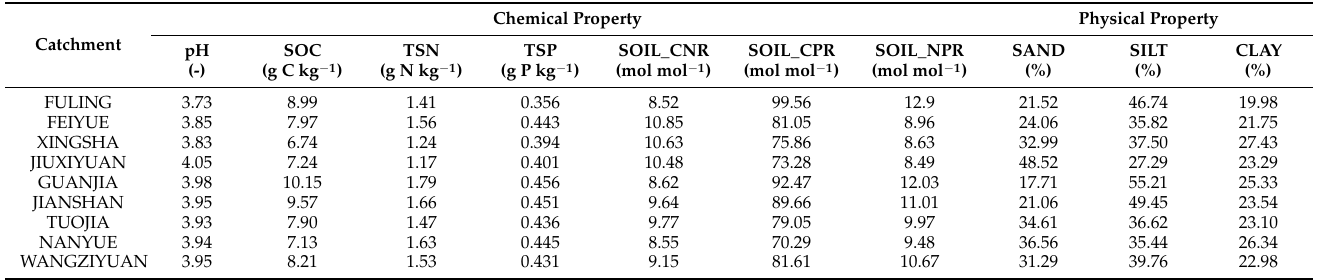
Table 5. Table 5. Area-averaged soil chemical and physical properties of the nine studied